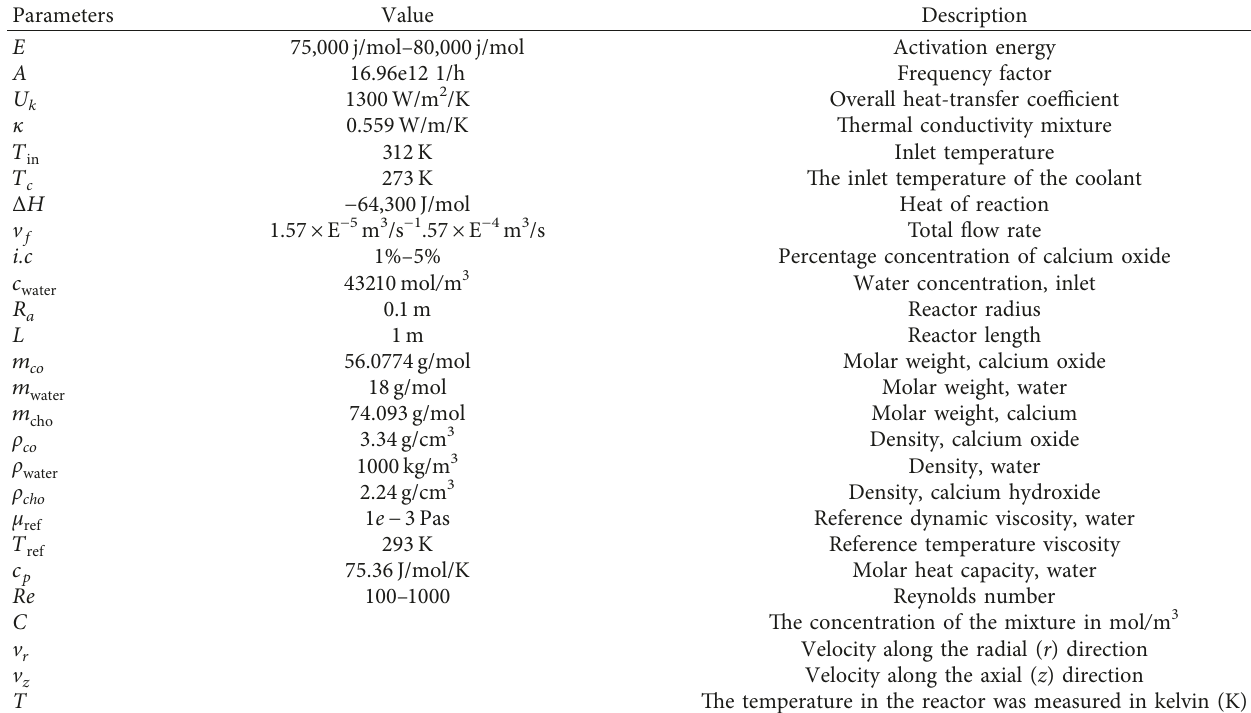
Figure 1: A short view of the multicomponent tubular Table 1: Summary of parameters.